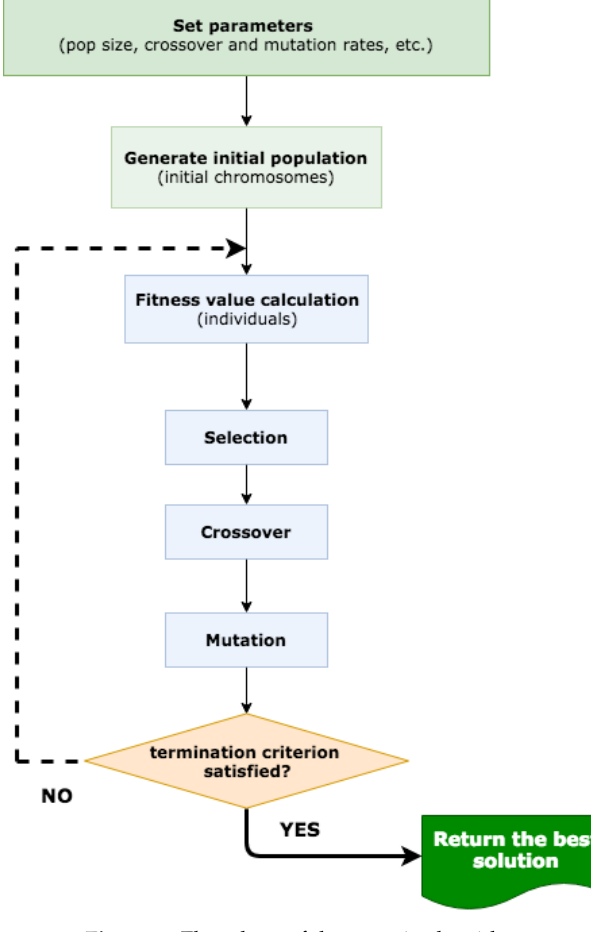
Figure 3. Flowchart of the genetic algorithm.